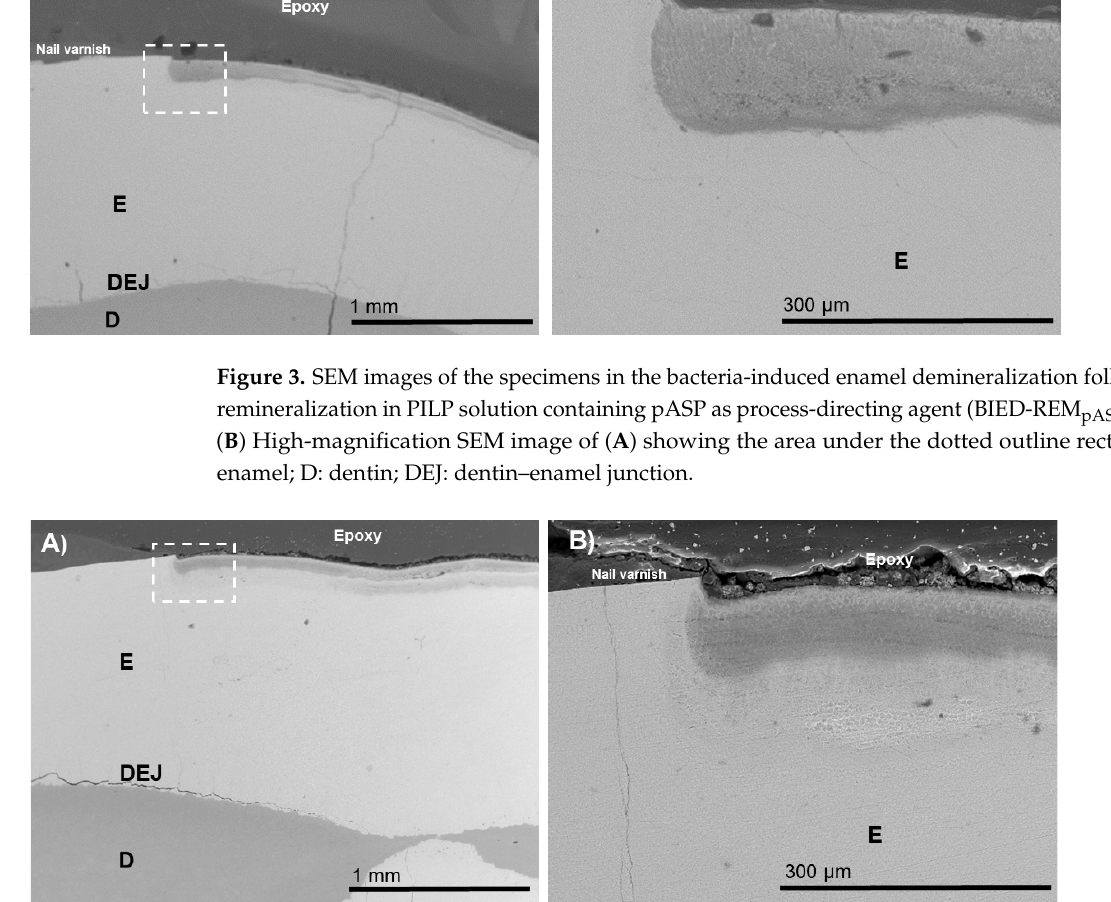
Figure 4. SEM images of the specimens in the bacteria-induced enamel demineralization followed by remineralization in PILP solution containing pASP as process-directing agent and fluoride (BIED- REM pASP - F group). ( B ) High-magnification SEM image of ( A ) showing the area under the dotted outline rectangle. E: enamel; D: dentin; DEJ: dentin–enamel